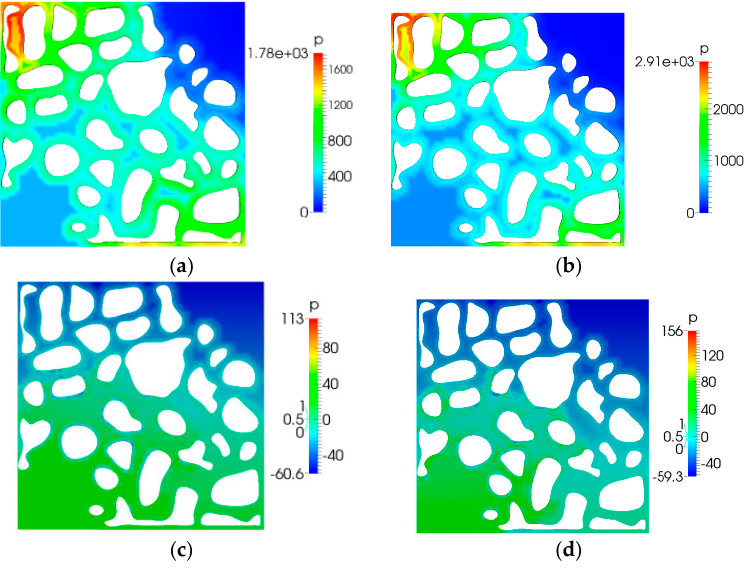
Figure 9. Volume fraction distribution ( t = 11 s): ( a ) water flooding; ( b ) no elastic polymer flooding; ( c ) viscoelastic polymer flooding ( λ = 0.01); and ( d ) viscoelastic polymer flooding ( λ = 0.03). Polymers 2018 , 10 , x FOR PEER REVIEW